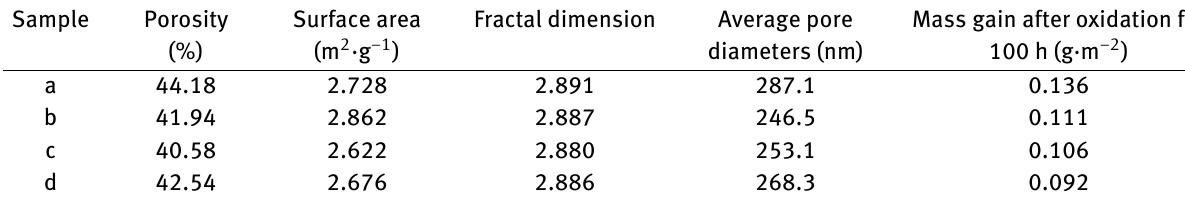
Table 1: Microstructure and oxidation behavior of sintered samples with different Mo contents